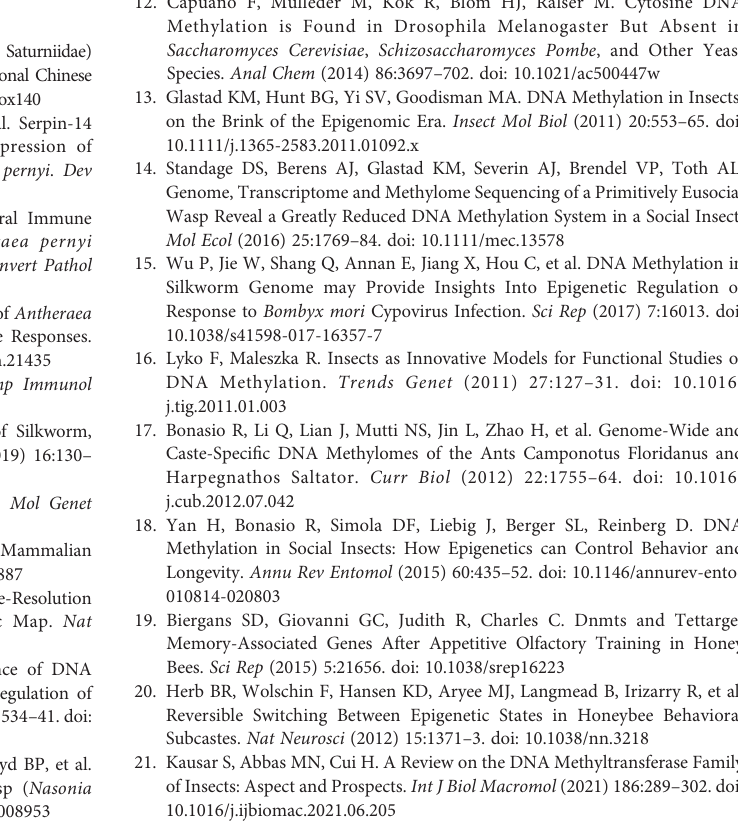
Supplementary Figure 1 | ApDNMT-1 nucleotide and deduced amino acid sequence of A. pernyi . The ApDNMT-1 deduced amino acid sequence is presented below the nucleotide sequence of cDNA, and the one-letter codes are aligned with the second nucleotide of each codon. The nucleotide and amino acid sequences are numbered at the left. Identi fi ed domains were labeled as DNMT1-RDF: DNA methyltransferase replication foci domain which is indicated by a red box, ZnF: Zinc fi nger domain is indicated by an orange colour box, BAH: Bromo adjacent homology domain is shown in yellow colour box, DCM: DNA-cytosine methyltransferases domain is shown in green box Cys-rich: cysteine-rich ADD domain is presented in a blue box. Supplementary Figure 2 | ApDNMT-2 nucleotide and deduced amino acid sequence of A. pernyi . The ApDNMT-2 deduced amino acid sequence is presented below the nucleotide sequence of cDNA, and the one-letter codes are aligned with the second nucleotide of each codon. The nucleotide and amino acid sequences are numbered at the left. The putative DNMT2 cyt_C5_DNA methylase superfamily domain is shown in the red